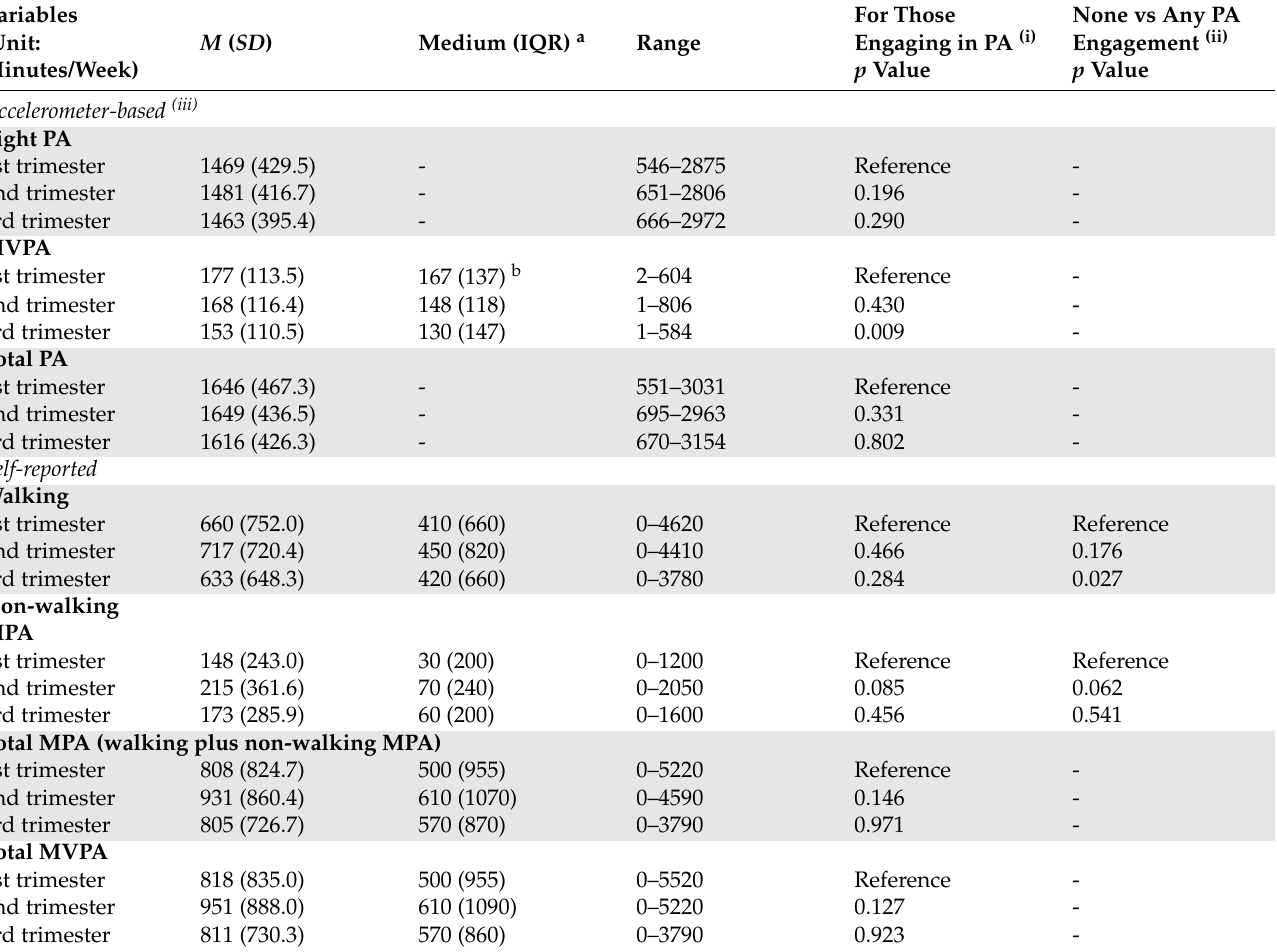
Table 2. Physical activity (PA) measures during pregnancy ( N =197, with 591 observations across three